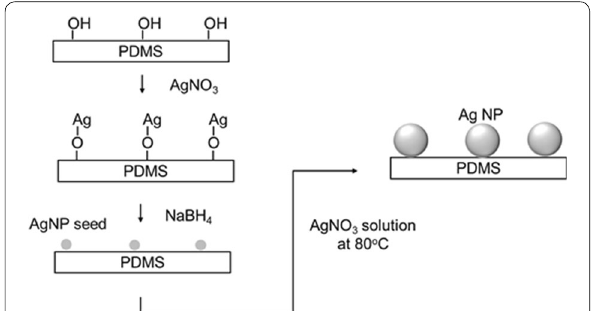
Fig. 1 Schematic illustration of the in situ synthesis of AgNPs on PDMS film